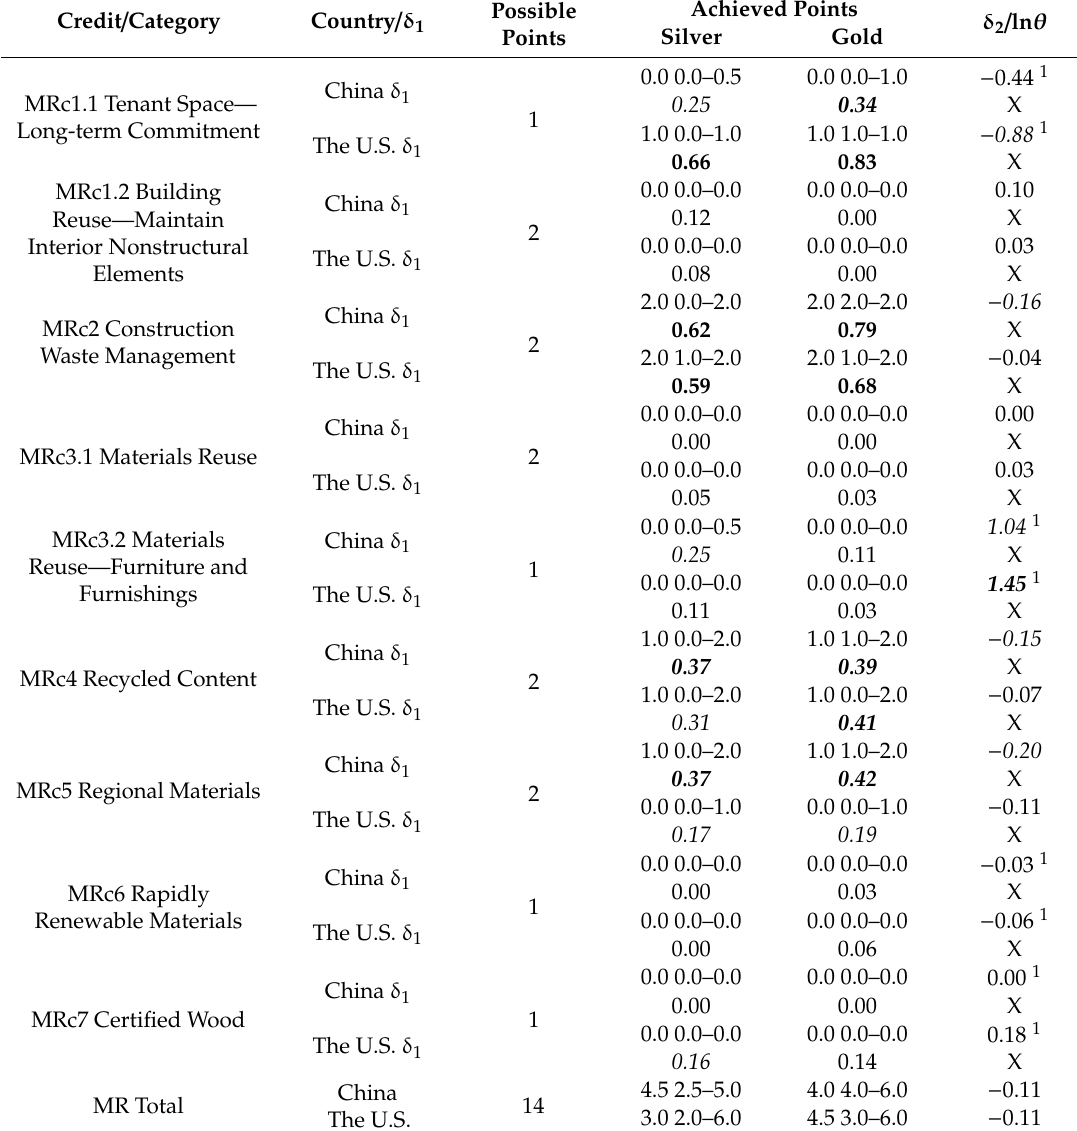
Table 7. LEED-CIv3 Materials and Resources (MR) credits category: The median and 25th–75th centiles and Cli ff ’s e ff ect size ( δ 1 ) of the di ff erence between the achieved and the possible points, and ( δ 2 ) or ln θ of the di ff erence between Silver and Gold projects in China and the